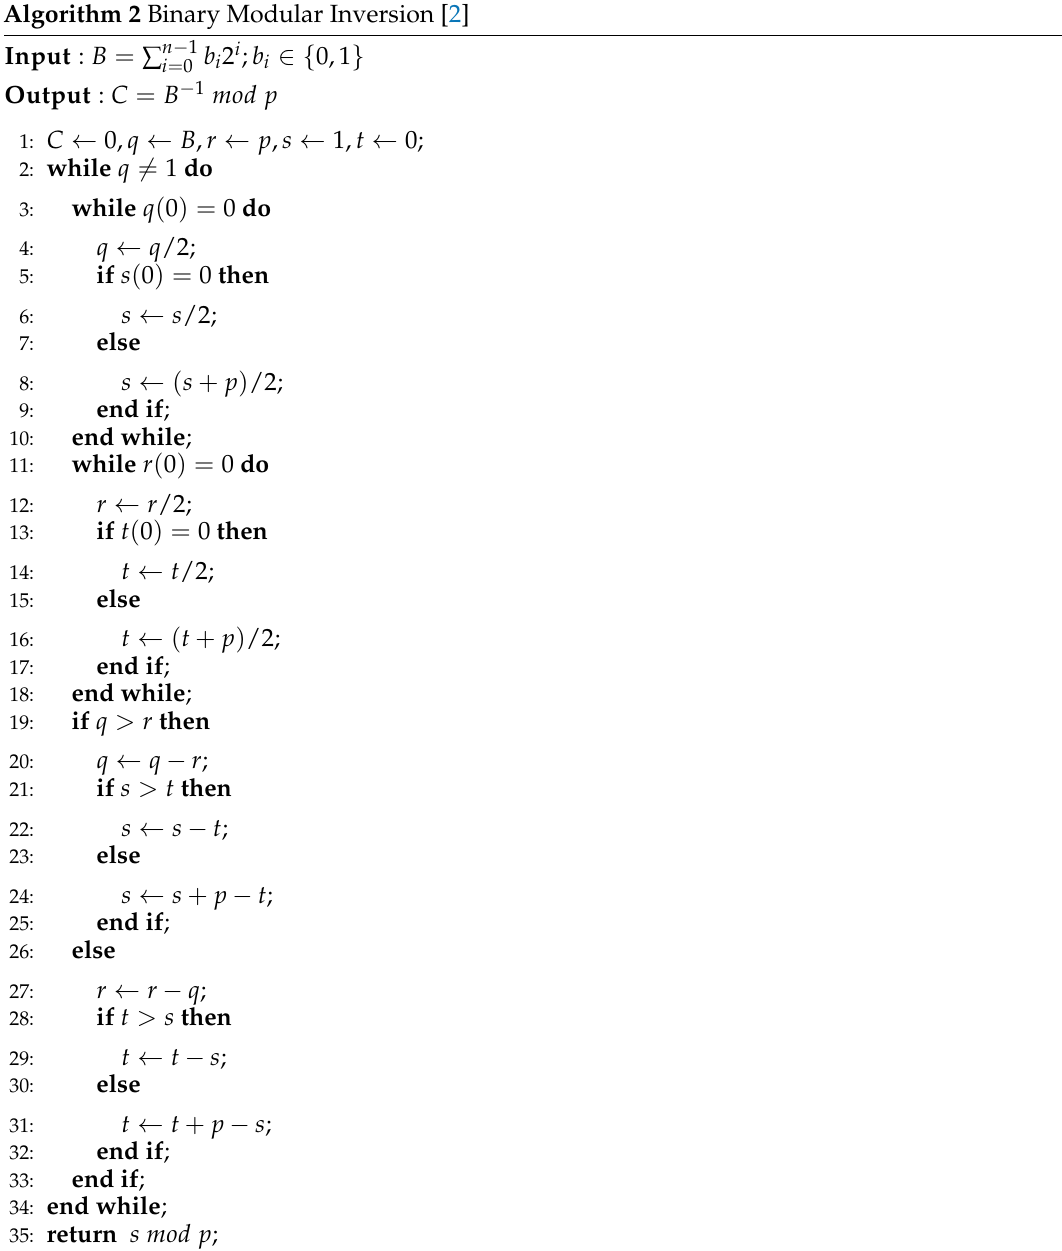
Algorithm 2 Binary Modular Inversion